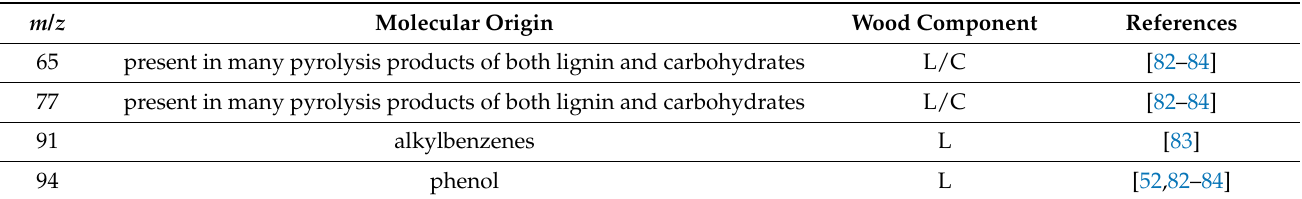
Table 2. Molecular assignment of the most abundant m / z values observed in the DE-MS mass spectra of lignin. L—lignin; C-carbohydrates; G—guaiacyl-lignin; S—syringyl-lignin. m / z Molecular Origin Wood